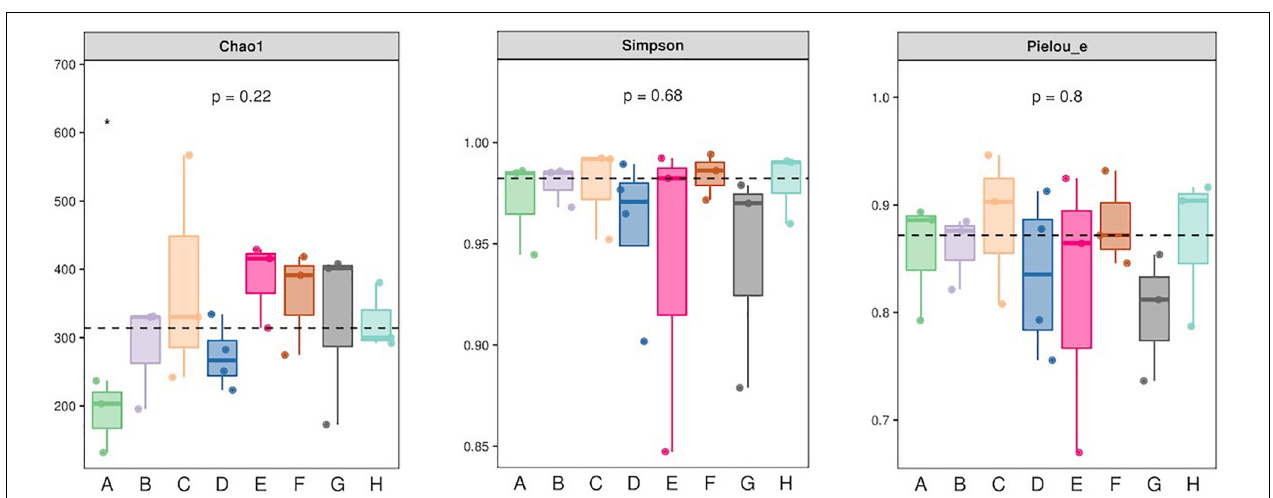
FIGURE 1 | Alpha analysis metrics for microbiota present in milk samples collected in eight locations for this study. A. Heilongjiang, B. Inner Mongolia, C. Gansu, D. Henan, E. Anhui, F. Jiangsu, G. Chongqing, and H. Hunan. *Significant difference.